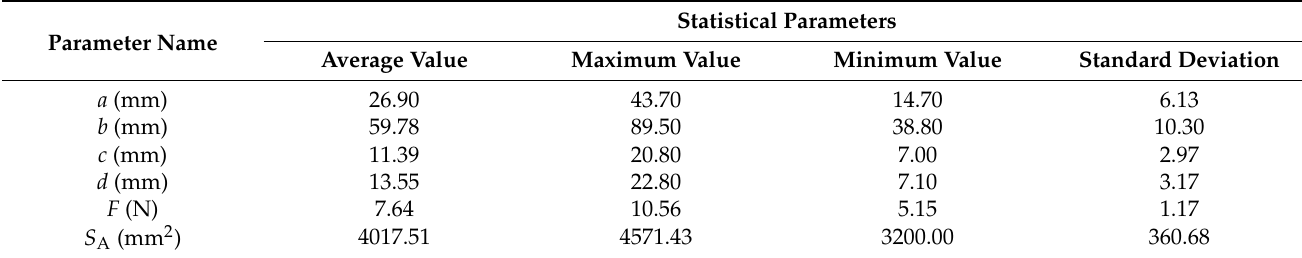
Table 1. Statistical table of the physical properties of tea.